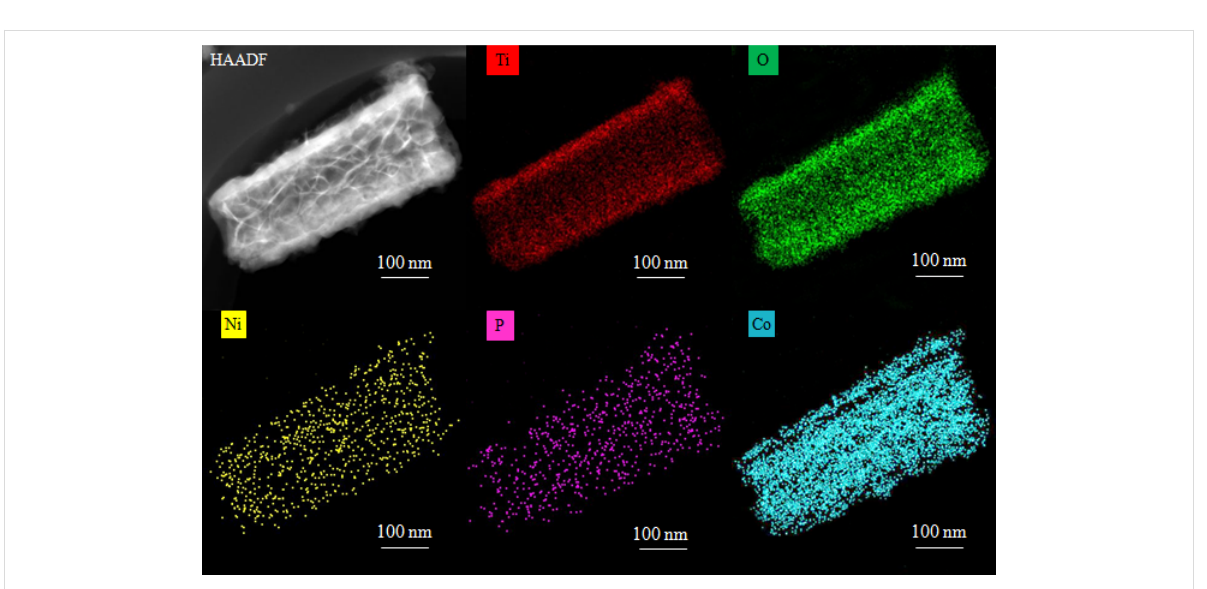
Figure 4: HAADF STEM image and EDS elemental maps of the Ni x Co y P/TNAs.